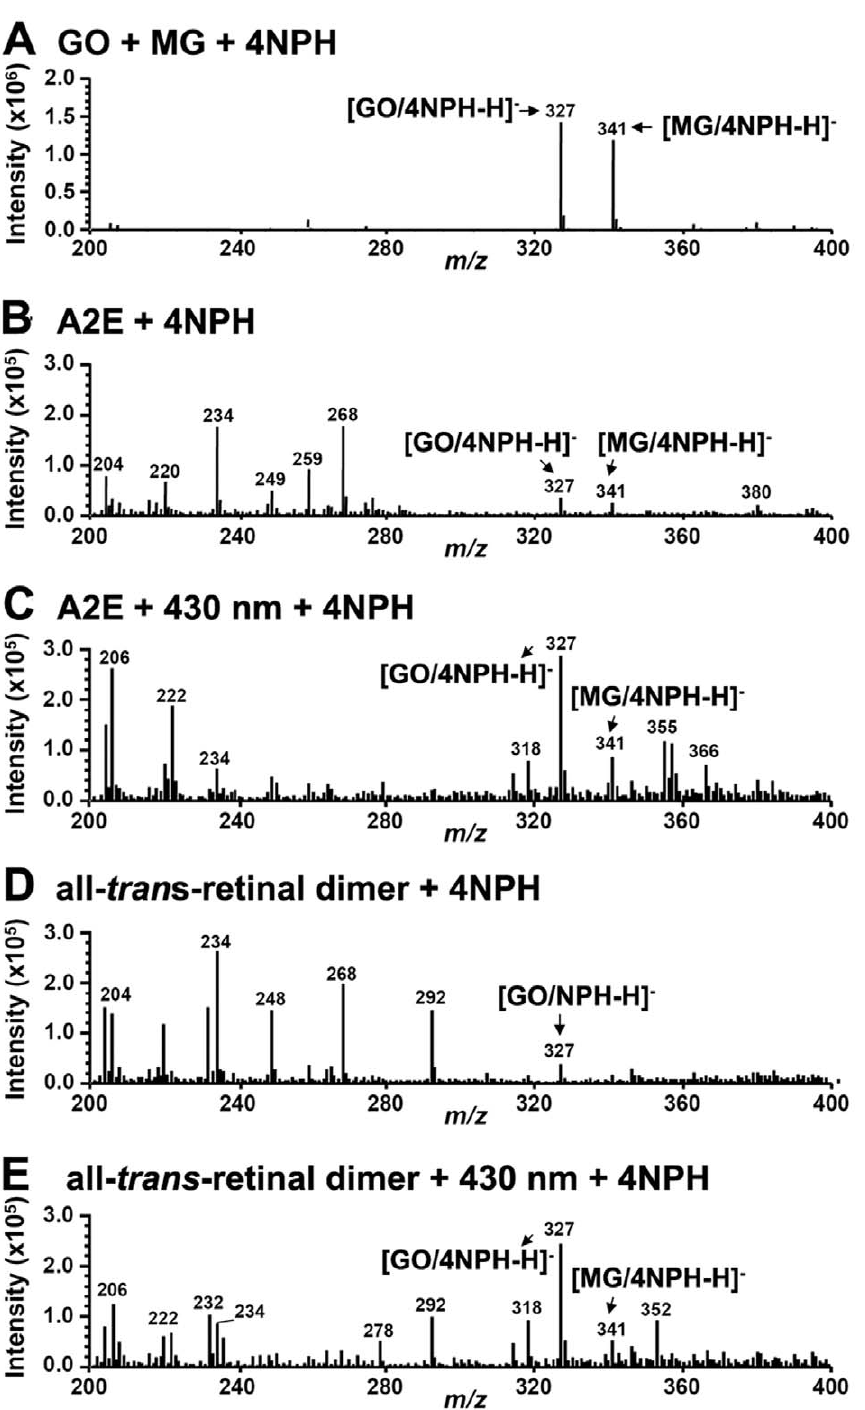
Figure 2. Irradiation (430 nm) of A2E and all -trans -retinal dimer leads to production of glyoxal (GO) and methylglyoxal (MG). Negative ESI-MS spectra in the range m/z 200–400. Detection of GO and MG by reaction with 4NPH. ( A ) Authentic standards. Incubation of 4NPH with GO and MG (obtained commercially) yielded products at m/z 327 ([GO/4NPH-H] - ) and m/z 341 ([MG/4NPH-H] - ), respectively. ( B ) Incubation of 4NPH with A2E. ( C ) Incubation of 4NPH with irradiated A2E. ( D ) Incubation of 4NPH with all-t rans -retinal dimer. ( E ) Incubation of 4NPH with irradiated all -trans -retinal dimer. Augmentation of the m/z 327 and m/z 341 peaks in the irradiated samples is indicative of photodegradation- associated release of GO and MG.